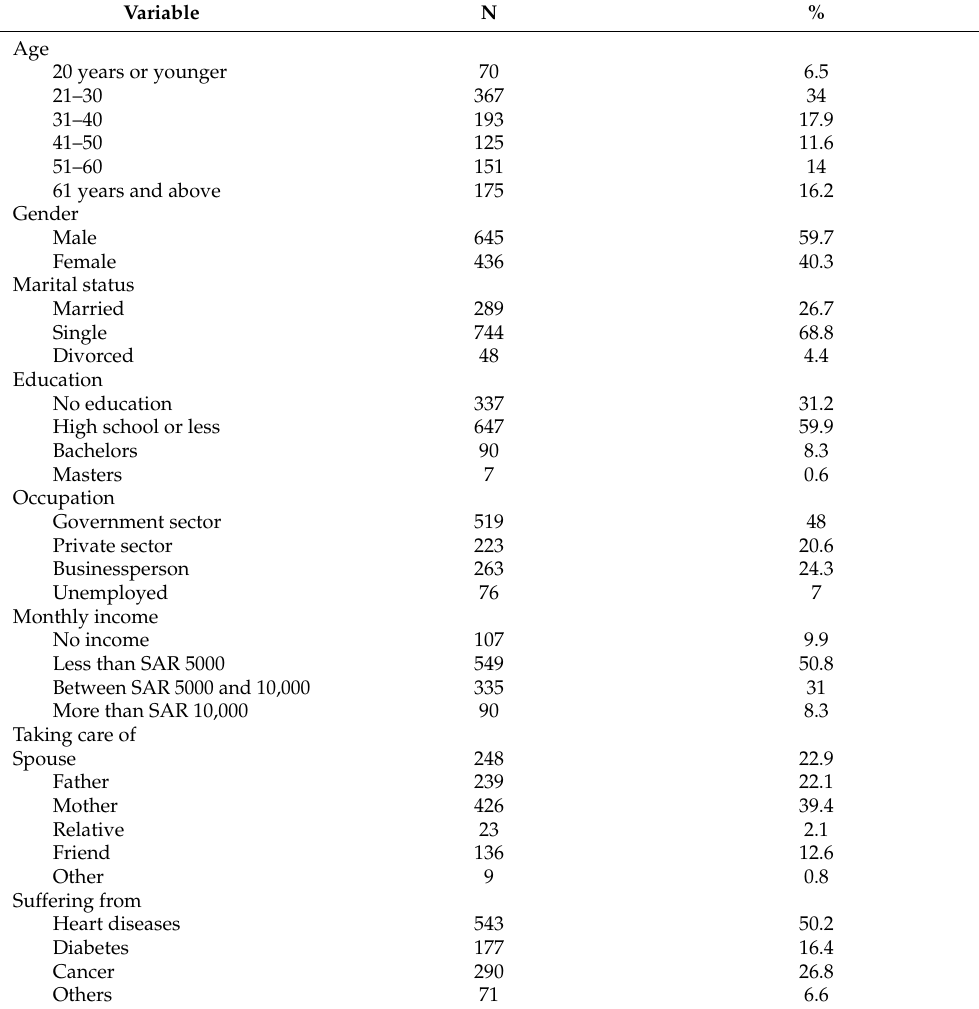
Table 1. Demographic characteristics of